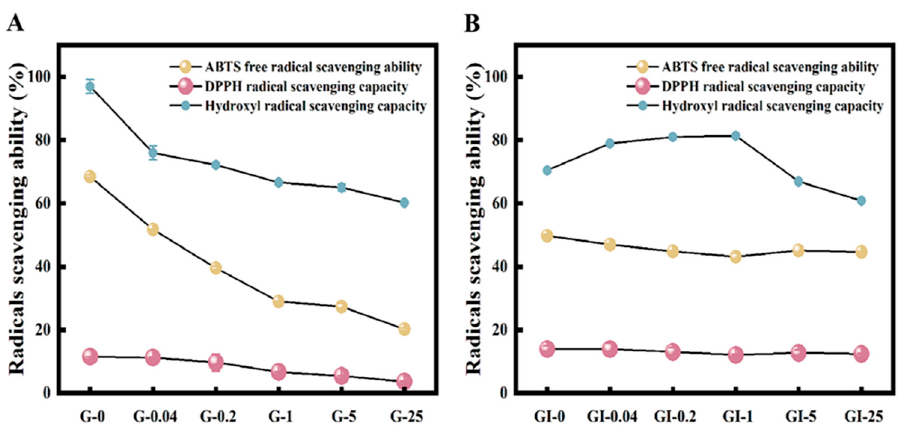
Figure 4. The antioxidant capacity of walnut isolated proteins after AAPH oxidation in gastric digestion ( A ) and subsequent intestinal digestion ( B ) for 2 h, respectively. G: gastric phase; GI: intestinal phase; 0, 0.04, 0.2, 1, 5, and 25 represent various AAPH concentrations (unit: mmol/L).